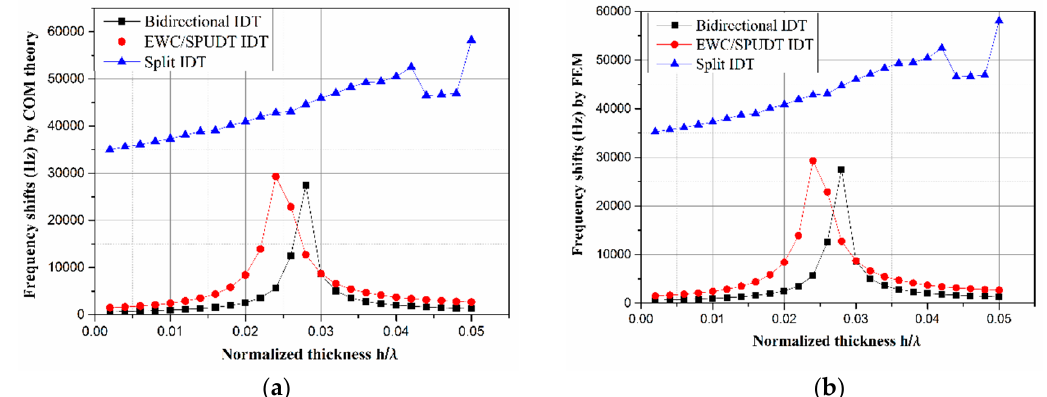
( c ) Figure 7. Reflectivity in different types IDTs: ( a ) bidirectional IDT, ( b ) EWC/SPUDT, and ( c ) split IDT. The frequency shifts